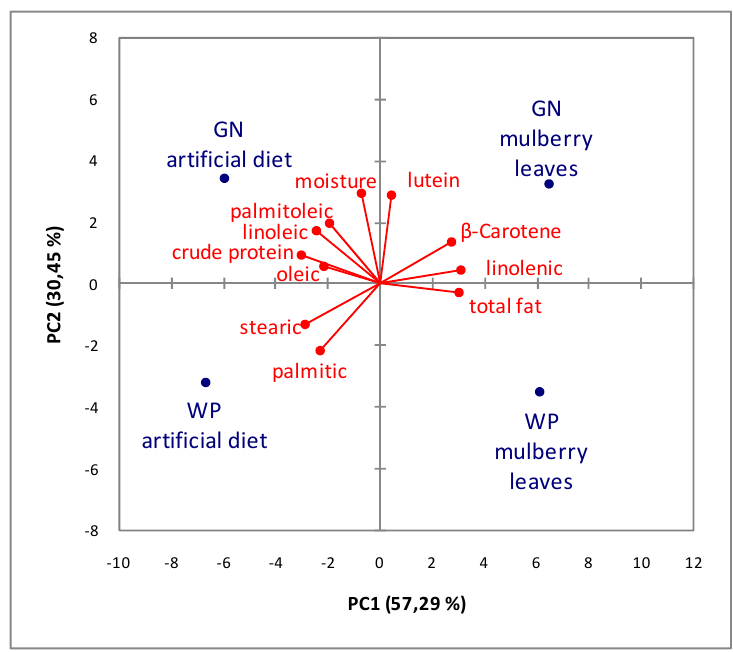
Figure 1. PCA analysis of the chemical composition of the silkworm pupae of Polyhybrid (WP) and Nistari (GN) strains fed an artificial diet (AD) and fresh mulberry leaves (ML).